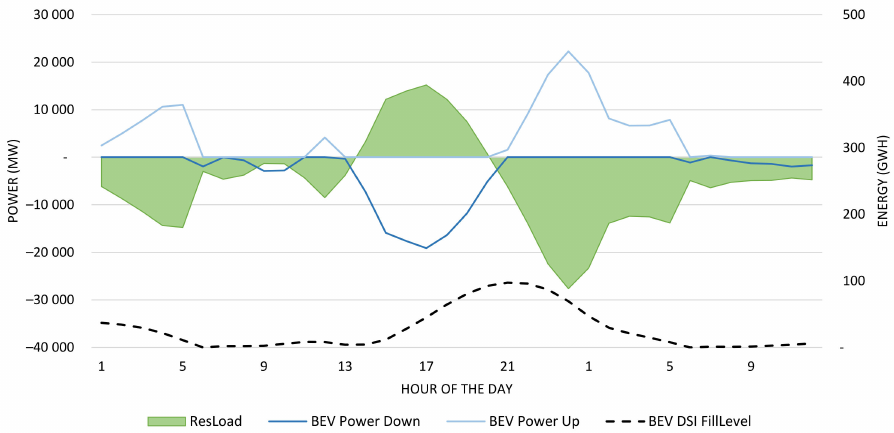
Figure 6. Use of BEV-DSI potential (PowerUp in light blue, PowerDown in blue) for 36 h to meet the residual load demands (ResLoad, green area). The corresponding fill level of the DSI storage is depicted in black dashes on the secondary